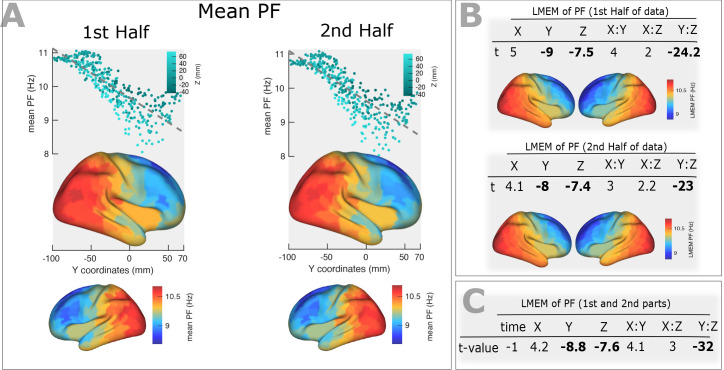
Stability of the PF gradient over time PF gradient along the posterior-anterior direction computed for 1 st and 2nd halves after splitting the time course to two equal segments.(A) Top panels: correlation between trimmed mean PF (187 participants, 384 ROIs) and ROI’s location along the y-axis (posterior to anterior) computed for the first (r = −0.82, p<0.001) and second (r = −0.81, p<0.001) halves of the time course. Points are colored according to their Z coordinates. Bottom panel: trimmed mean PF values mapped on the cortex surface. (B) T-values obtained from linear mixed effect modeling of PF as a function of coordinates of the ROI centroids, obtained from the first half (top panel) and the second half (bottom panel) of the time course. Cortical maps below each table shows the fixed effects of the LMEM. (C) Linear mixed effect modeling of PF as a function of the time and centroid coordinates. We defined the time as a categorical variable (‘1 st half’, ‘2nd half’) and added it to our LMEM, where we defined PF as a function of centroid coordinates, their interactions and time. The statistical model showed a non-significant effect of time (t = −1, p>0.05) on our results. This analysis shows that the spatial gradient of PF along the posterior-anterior direction is stable over time.